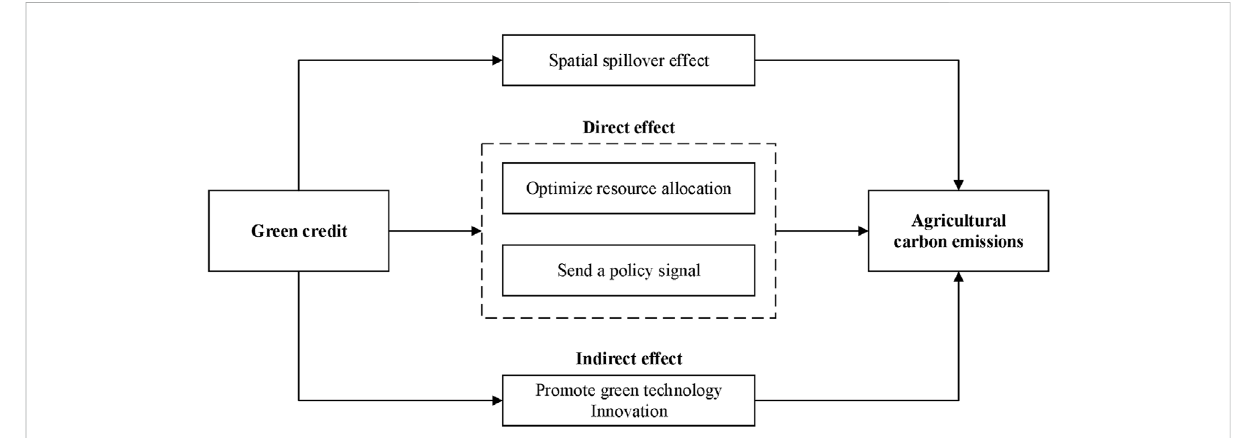
FIGURE 1 The theoretical framework of the green credit on agricultural carbon